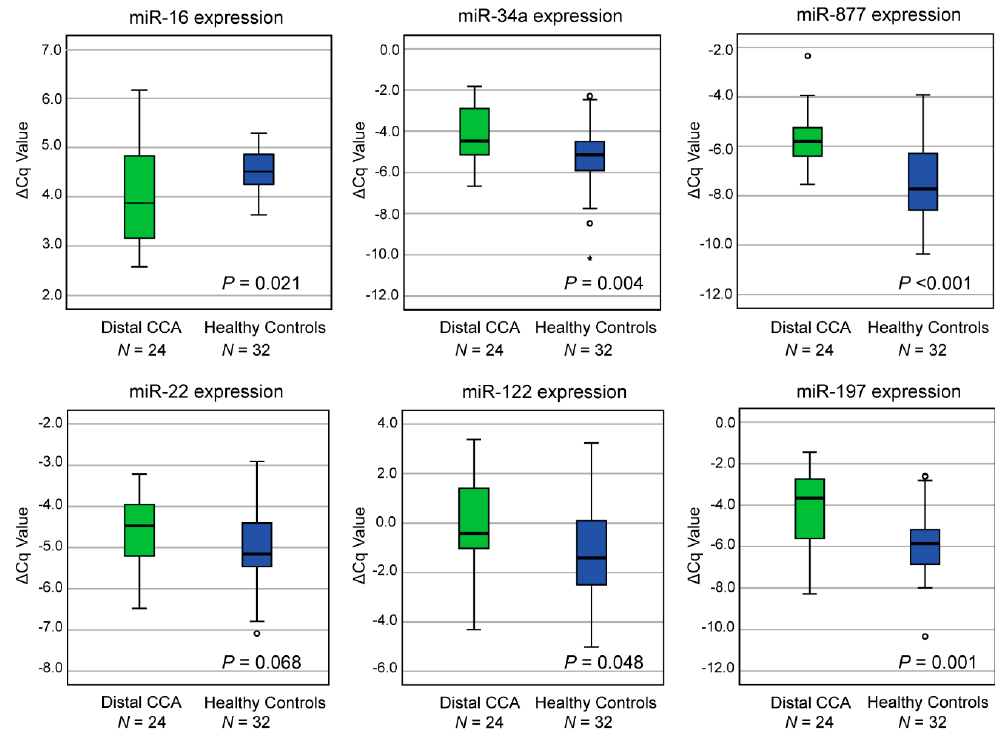
Figure 2. Evaluation of candidate miRNAs in patients with distal CCA compared to healthy individuals. Normalized expression levels ( ∆ Cq values) of each miRNA in the evaluation phase. Expression levels of distal CCA and healthy controls are shown, with horizontal lines representing mean and standard deviation. Distal CCA = distal cholangiocarcinoma.